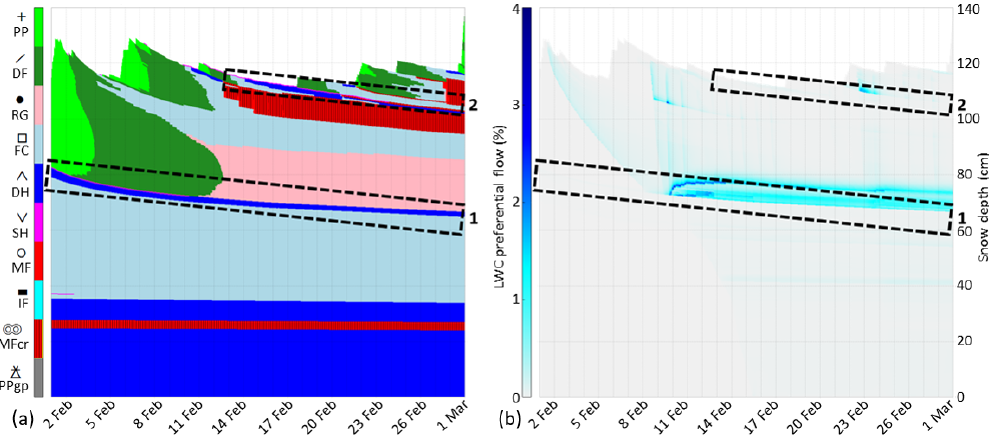
Figure 12. SNOWPACK simulation RE/PF/IceR in February 2017 at WFJ: (a) grain shape according to the classification of Fierz et al. (2009), and (b) liquid water content in the PF domain. Rectangles highlight layers 1 and